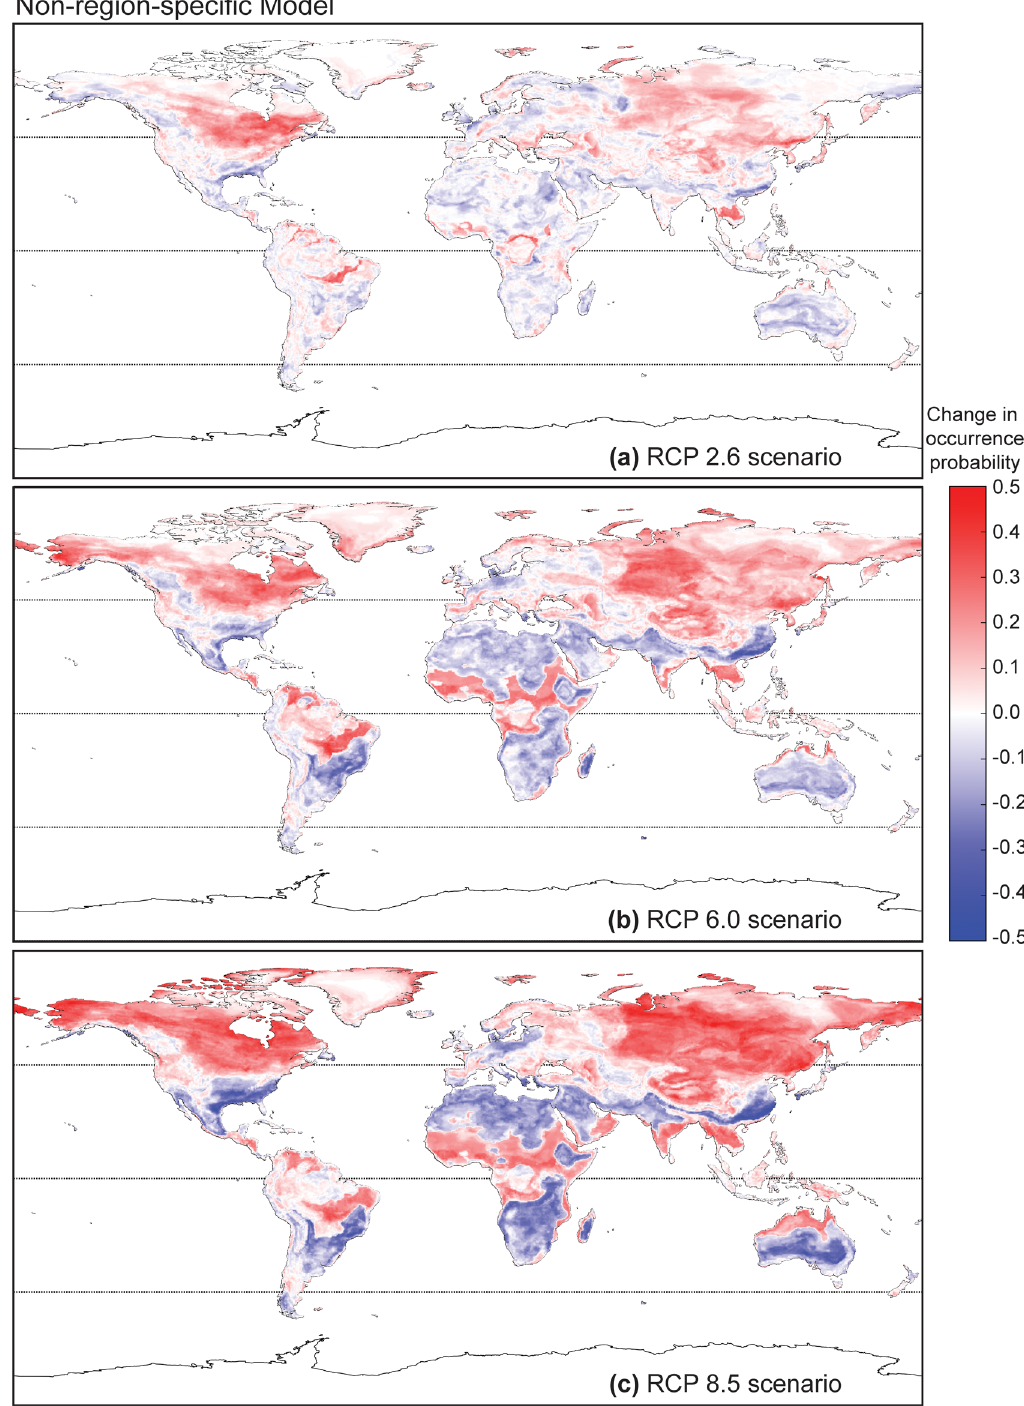
Fig 5. Predicted change in occurrence probability of amphibian chytrid fungus ( Batrachochytrium dendrobatidis ) based on future climate conditions using a non-region-specific global model. Predicted change in occurrence probability of Batrachochytrium dendrobatidis determined using the non-region-specific global model with future climate conditions forecasted for 2100 using RCP 2.6, 6.0 and 8.5 scenarios.